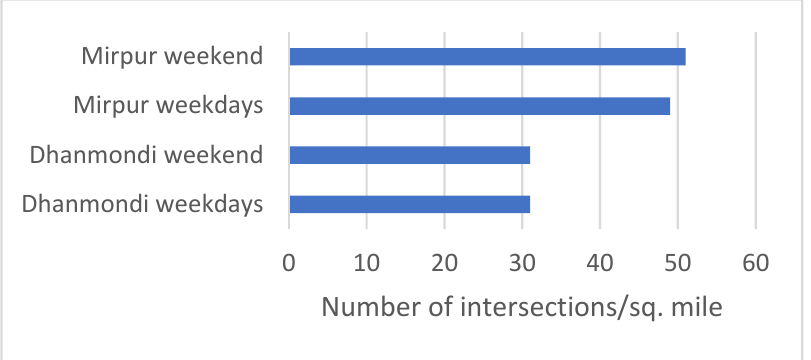
Figure 10. Study sub-area-wise intersection density during weekdays and weekends.